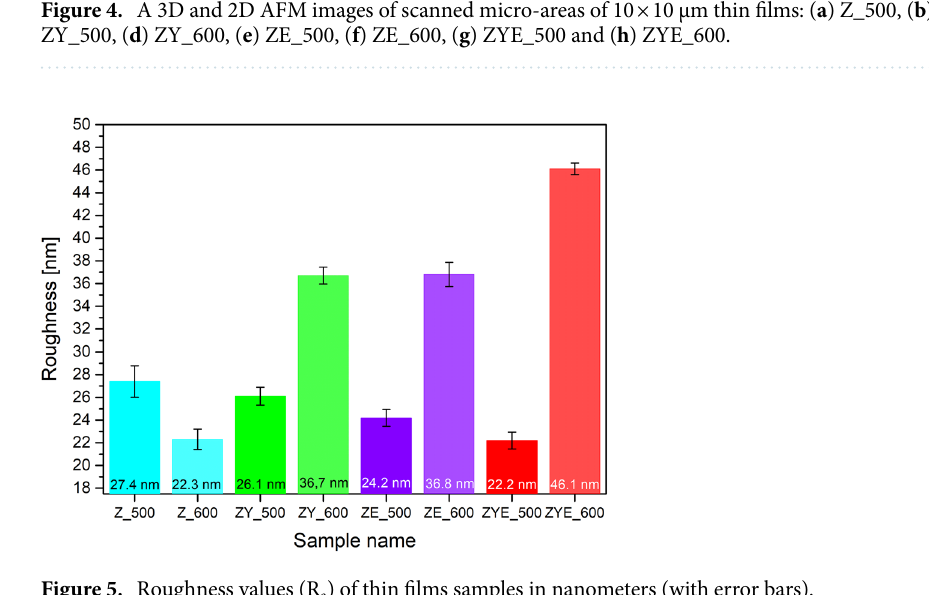
Figure 5. Roughness values (R a ) of thin films samples in nanometers (with error